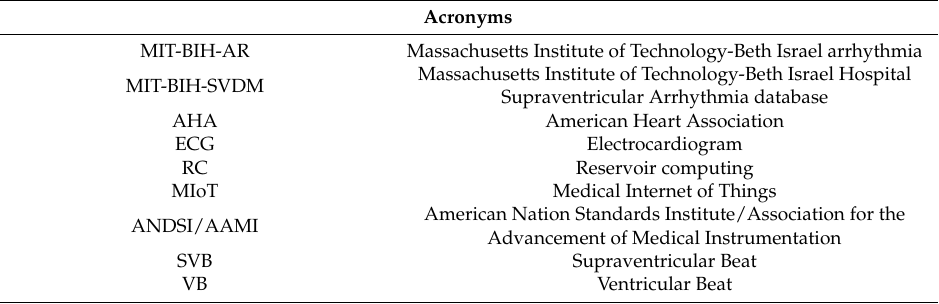
Table 1. List of acronyms used in this study.